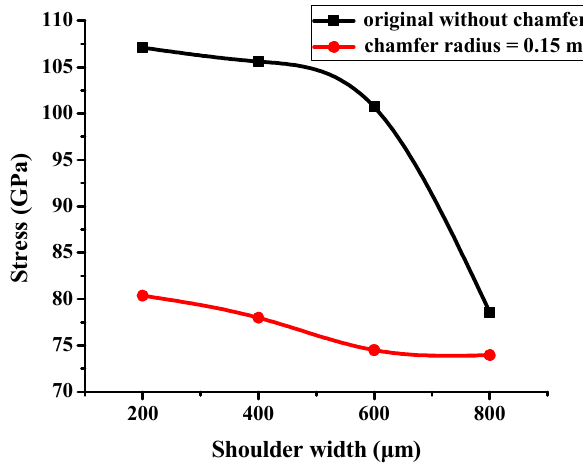
Figure 21. Comparison between the original design and the chamfer design.